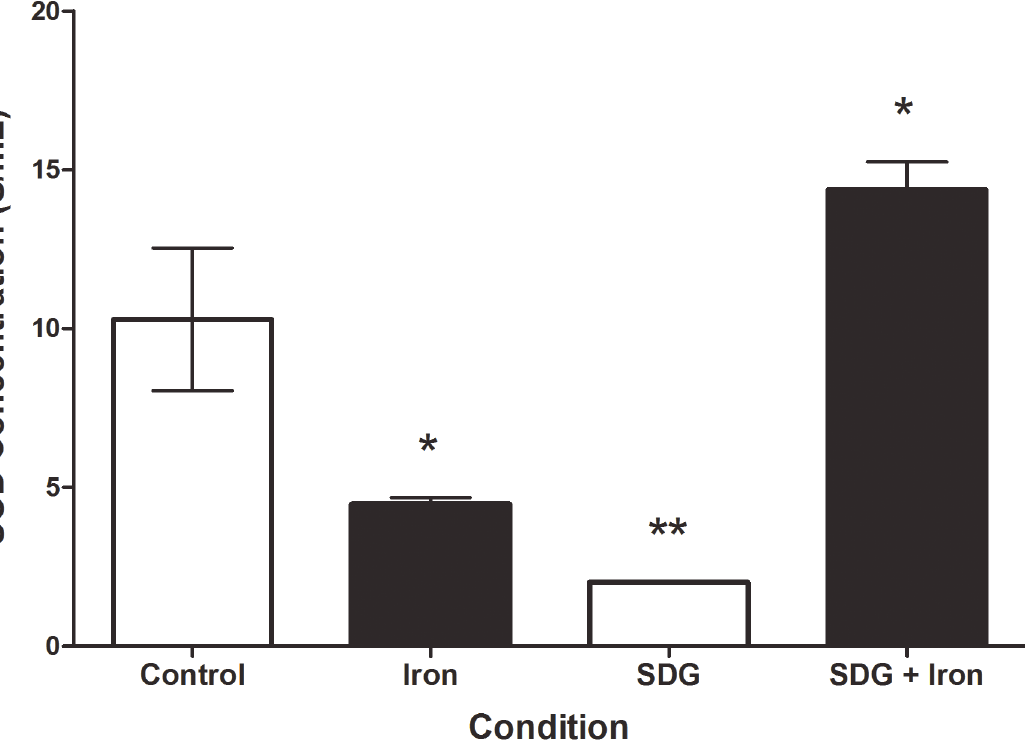
Fig 3. SDG increases SOD concentration in iron treated H9c2 cells. SOD concentration in control, 50 μ M iron-treated, 500 μ M secoisolariciresinol diglucoside (SDG), and SDG pre-treatment + iron-treated H9c2 cells. SOD concentration was assessed via a colourimetric assay. Data is expressed as SOD concentration (U/mL). ( ** = p < 0.01 versus control; * = p < 0.05 versus control, n = 3).